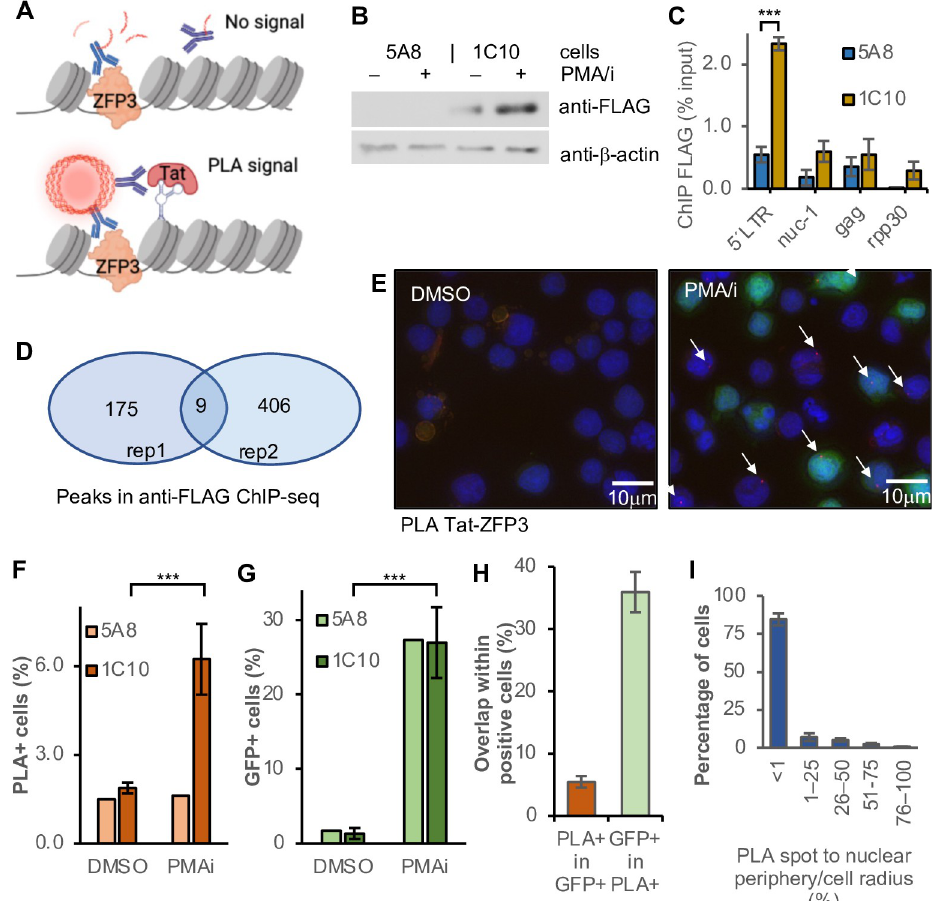
Fig 1. PLA detects Tat at the HIV-1 promoter. (A) The HIV-1 promoter with the zinc finger protein ZFP3 (orange), and an adjacent protein, here Tat (pink) recognized by two oligonucleotide-conjugated antibodies that are ligated to enable rolling circle amplification, and subsequent binding of fluorescently labelled probes during PLA. (B) Immunoblot using antibody against FLAG in 1C10 cells, a clone of HIV-1 containing J-lat 5A8 cells infected with FLAG-tagged ZFP3, and parental 5A8 cells treated with DMSO or PMA/i for 24 h. (C) ChIP-qPCR of FLAG in 1C10 and 5A8 cells ( n = 3, s.e.m.). (D) Venn diagram of MACS2 peaks (filtered: -log(q) > 5) from ChIP-seq with anti-FLAG in 1C10 cells ( n = 2). (E) PLA with 1C10 cells treated with DMSO or PMA/i for 16 h. Nuclei were stained with DAPI, green shows GFP expression and red shows PLA spots. White arrows points to the PLA spots. (F–G) Quantification of Tat-ZFP3 PLA + cells (F) and GFP + cells (G), (H) The overlap between GFP + and Tat-ZFP3 PLA + cells. (I) Distance of PLA spots to nuclear periphery ( n = 5). (B, F, G) Student t-test p-values � p < 0.05, �� p < 0.01, ��� p < 0.005. manner. A specific protein, ZFP3, has been artificially constructed to recognize the HIV-1 pro- moter, adjacent to the NF κ B binding sites [41]. We cloned a FLAG-labelled ZFP3 protein into a lentiviral plasmid under the SFFV promoter. The ZFP3 sequence was linked to the BFP sequence through the sequence for a self-cleaving P2A peptide. Lentiviral particles were trans- duced into J-lat 5A8 cells, a Jurkat cell line harboring a single copy of latent HIV-1 [42,43]. The latent reporter HIV-1 in 5A8 cells is a full-length mutated provirus where env has a frame- shift mutation and nef is replaced by a GFP coding sequence. After clonal expansion of ZFP3-BFP transduced cells, for further studies we selected a clone, 1C10, with 96.4% ZFP3 positive cells, as identified by BFP expression (S1A Fig). The FLAG-ZFP3 protein was present in 1C10 cells in both unstimulated cells and cells stimulated with phorbol 12-myristate 13-ace- tate and ionomycin (PMA/i) as confirmed by immunoblotting (Fig 1B). Cell stimulation with